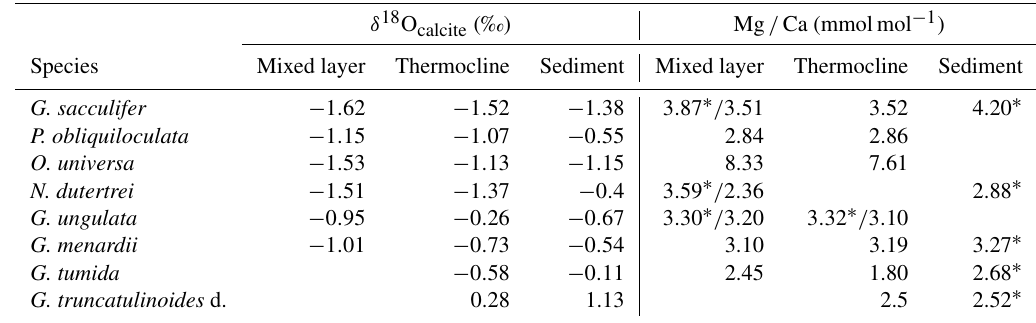
Table 3. Average values of δ 18 O calcite and Mg / Ca (measured on ICP-OES ∗ and LA-ICP-MS) from the mixed layer, thermocline and surface sediment (see Sect. S1 for data). PF samples are not included in the